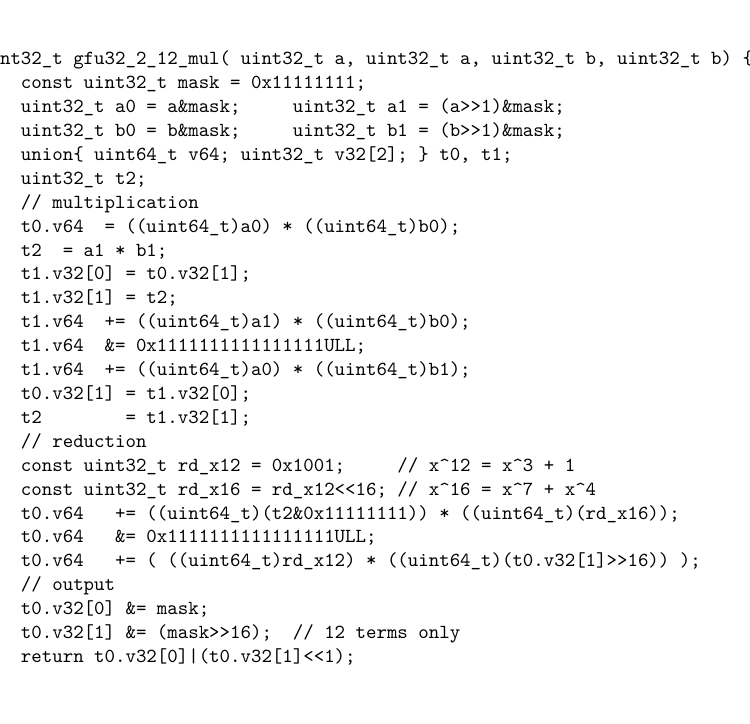
Figure 4: Multiplication of F